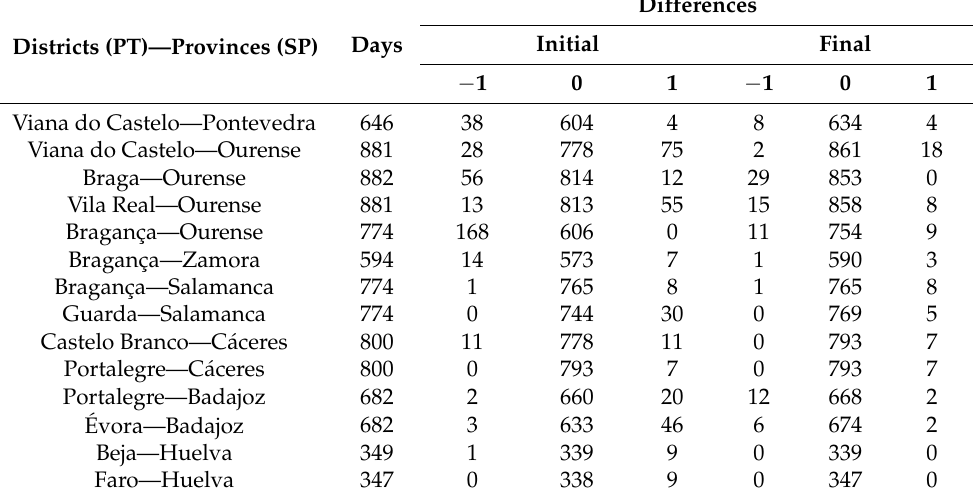
Table 5. Number of days in which the fire danger class estimated in Portugal was one level lower than the class estimated in Spain ( − 1), number of days with perfect agreement (0), and number of days in which the fire danger class estimated in Portugal was one level lower than the class estimated in Spain